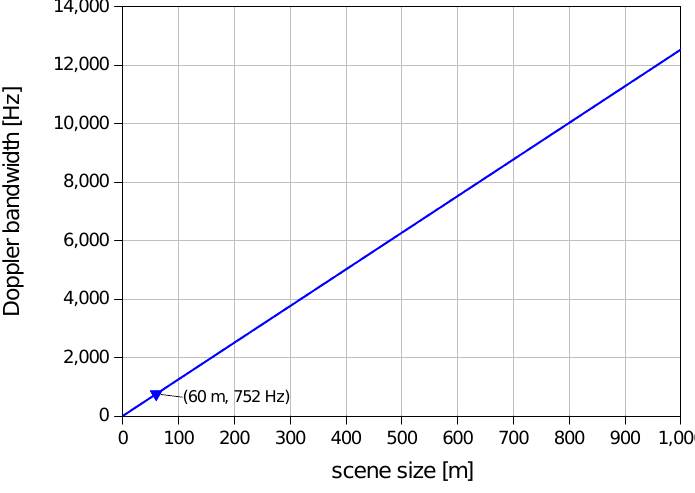
Figure 4. Doppler bandwidth limited by scene